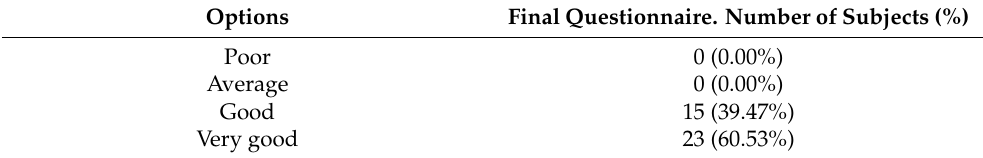
Table 9. Item 7: Professor assessment when explaining how dose calculation simulator